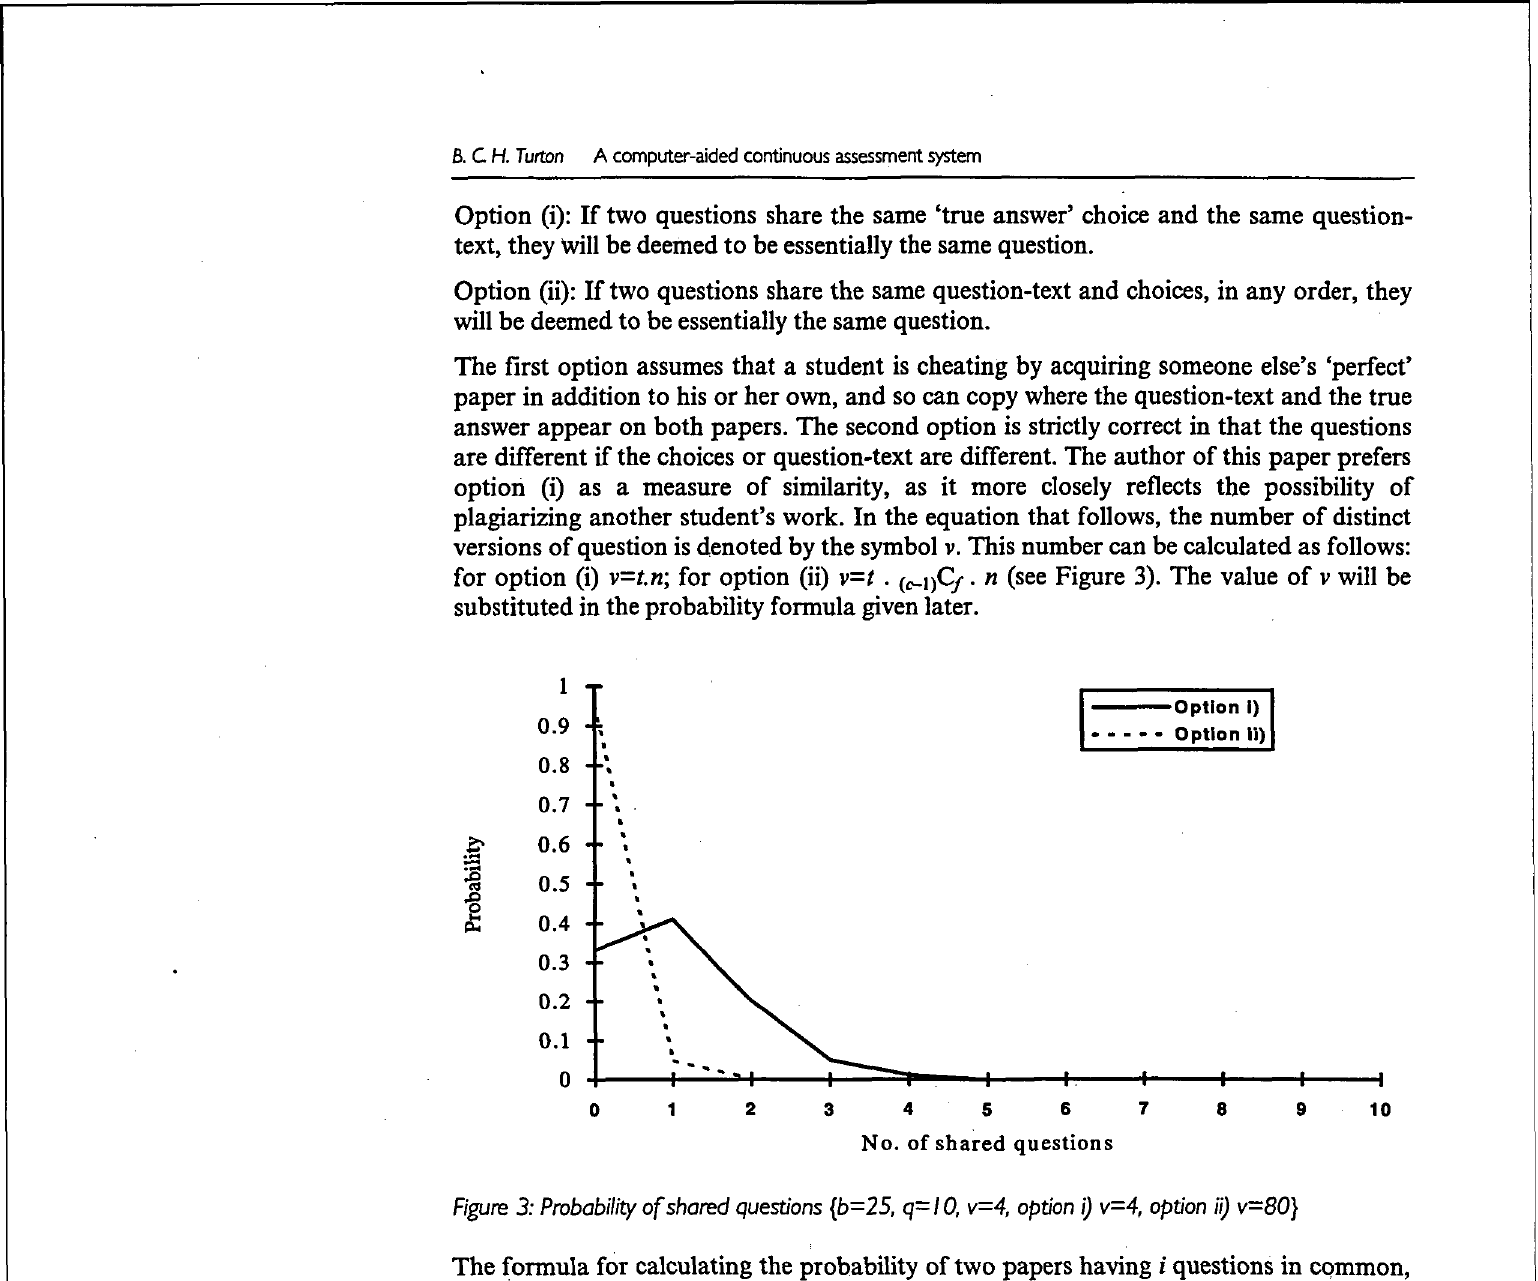
Figure 3: Probability of shared questions {b=25, q=IO, v=4, option i) v=4, option ii)